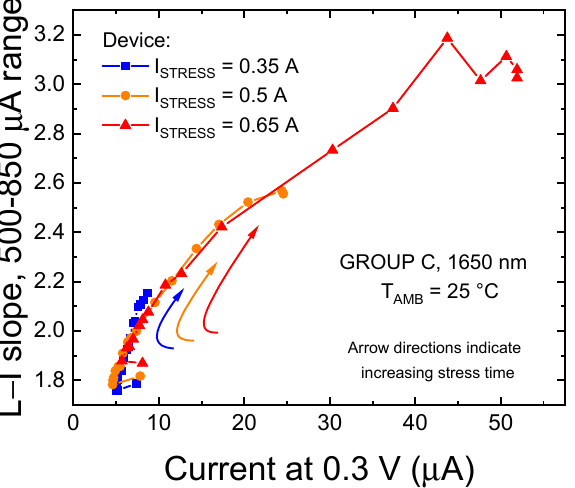
Figure 11. Correlation between the forward leakage current of the LED, measured at 0.3 V and T AMB = 25 °C, and the slope of the L-I characteristics, calculated in the 500–850 μ A range. Data related to the CC stress at T SRESS = 45 °C on a group C device.